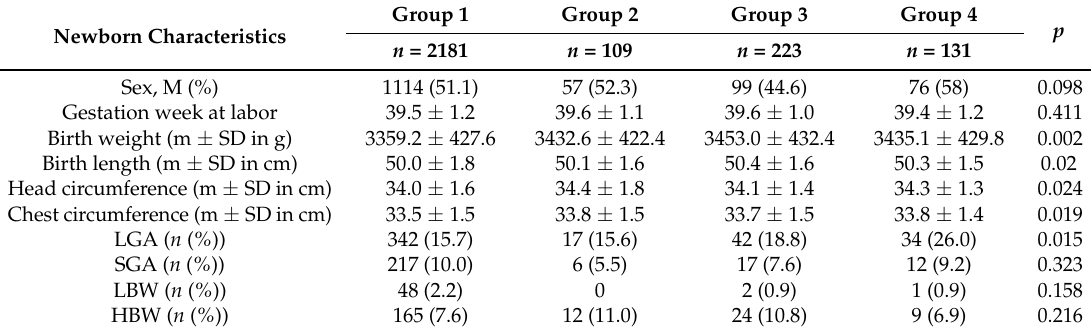
Table 2. Characteristics of 2644 newborns according to FA supplementation use after the first trimester of